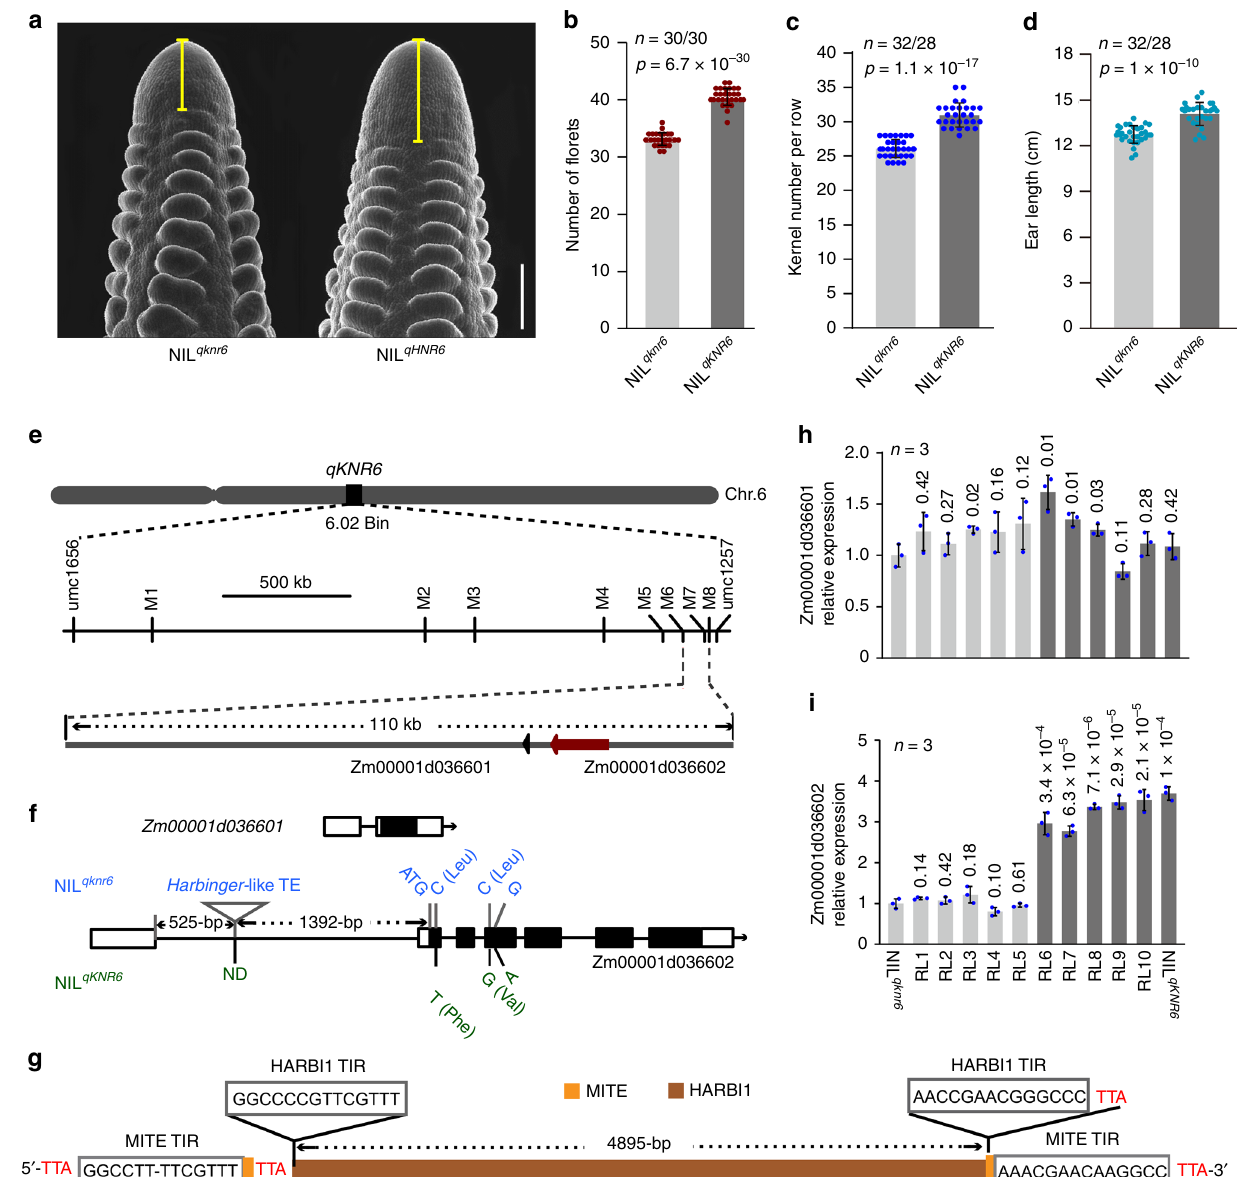
Fig. 1 Phenotype of two QTL parental lines and map-based cloning of qKNR6 . a Ear in fl orescence meristems of the two parents. Scale bar = 500 μ m. b – d Comparisons of fl oret number ( b ), EL ( c ), and KNR ( d ) between NIL qknr6 and NIL qKNR6 grown in the fi eld at Sanya, China in 2015. The values in ( b – d ) are shown as the means ± s.d., and signi fi cance was estimated by the one-way ANOVA. The numeral on the bottom of each column is the number of ears examined. e Fine mapping of qKNR6. qKNR6 was located on chromosome 6, bin02. The re fi ned 110_kb region at the qKNR6 locus contained two genes, Zm00001d036601 and Zm00001d036602 . f Gene structure of two candidate genes and polymorphisms between the two parents. No polymorphism is identi fi ed in Zm00001d036601 , but three SNPs in exons and a Harbinger-like TE (triangle) in the 5 ′ -UTR intron of Zm00001d036602 were detected. g